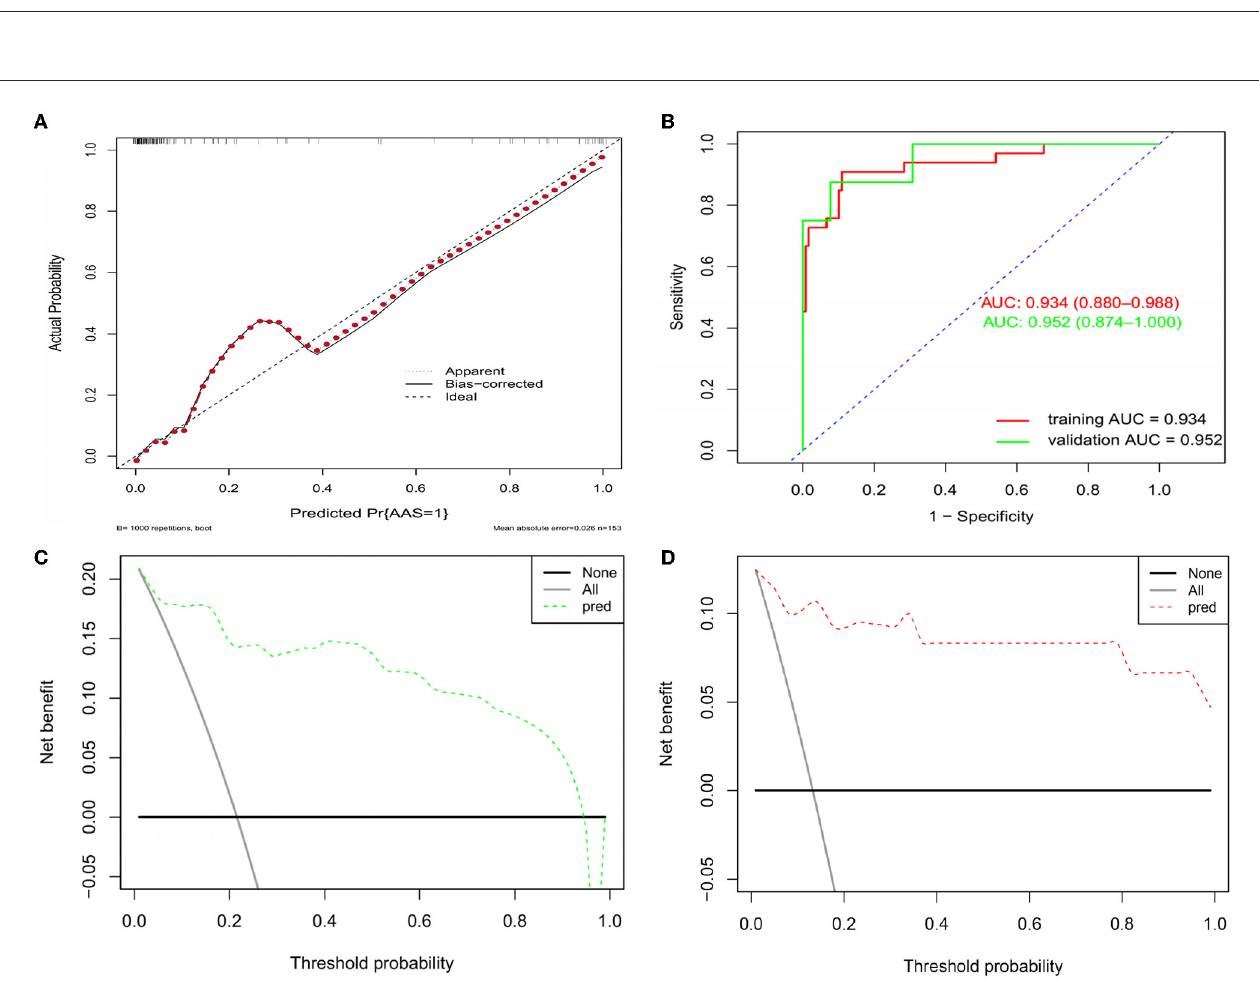
FIGURE2 The nomogram model used for discriminating AAS from NSTEMI with chest pain onset at ≥ 2h. D-dimer/(ng/mL) > 840 calculated as 840; fibrinogen (g/L) < 2 calculated as 2; age (years) < 32 calculated as 32. AAS, acute aortic syndrome; NSTEMI, non-S T- elevation myocardial infarction.